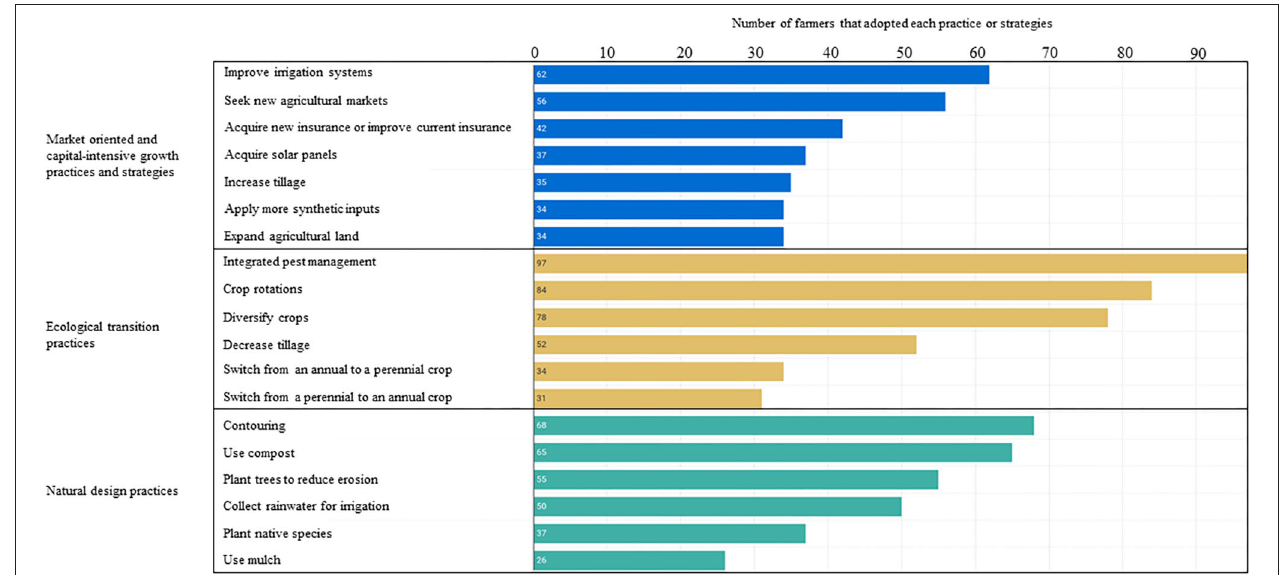
FIGURE 1 | Farmers’ reported actual adoption of adaptation practices and strategies after Hurricane Maria.